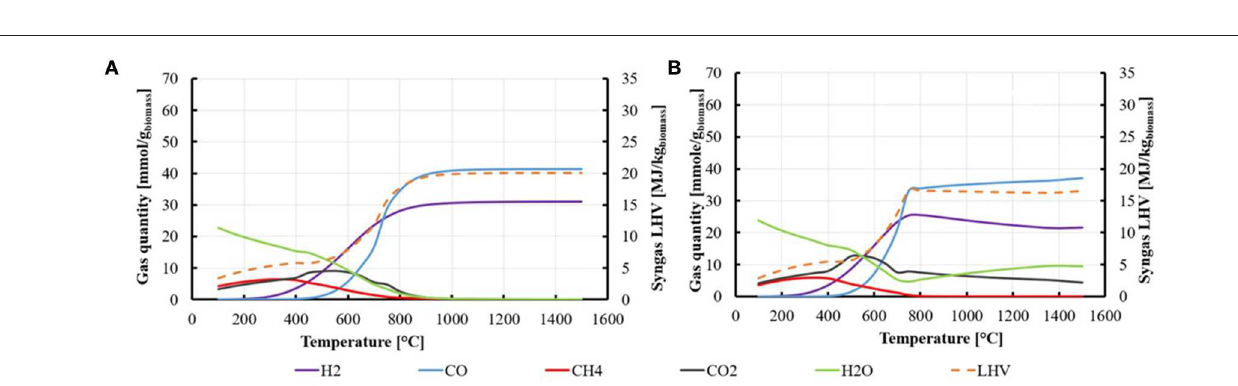
FIGURE 3 | Quantity of gases produced at thermodynamic equilibrium per gram of dry biomass from gasification of wood with iron oxide according to temperature: (A) stoichiometric proportion C 6 H 9 O 4 + 2 Fe 2 O 3 ; (B) over-stoichiometric proportion C 6 H 9 O 4 + 2Fe 2 O 3 . 3